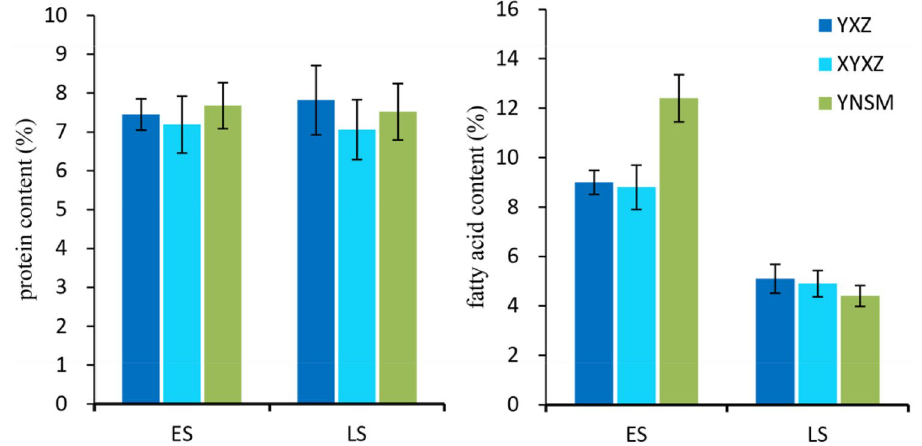
Figure 5. Protein and fatty content analysis. ES, early season; LS, late